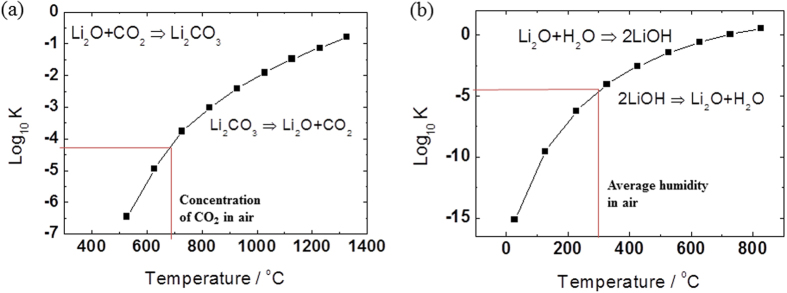
Phase diagram of Li2CO3 and LiOH as a function of temperature.